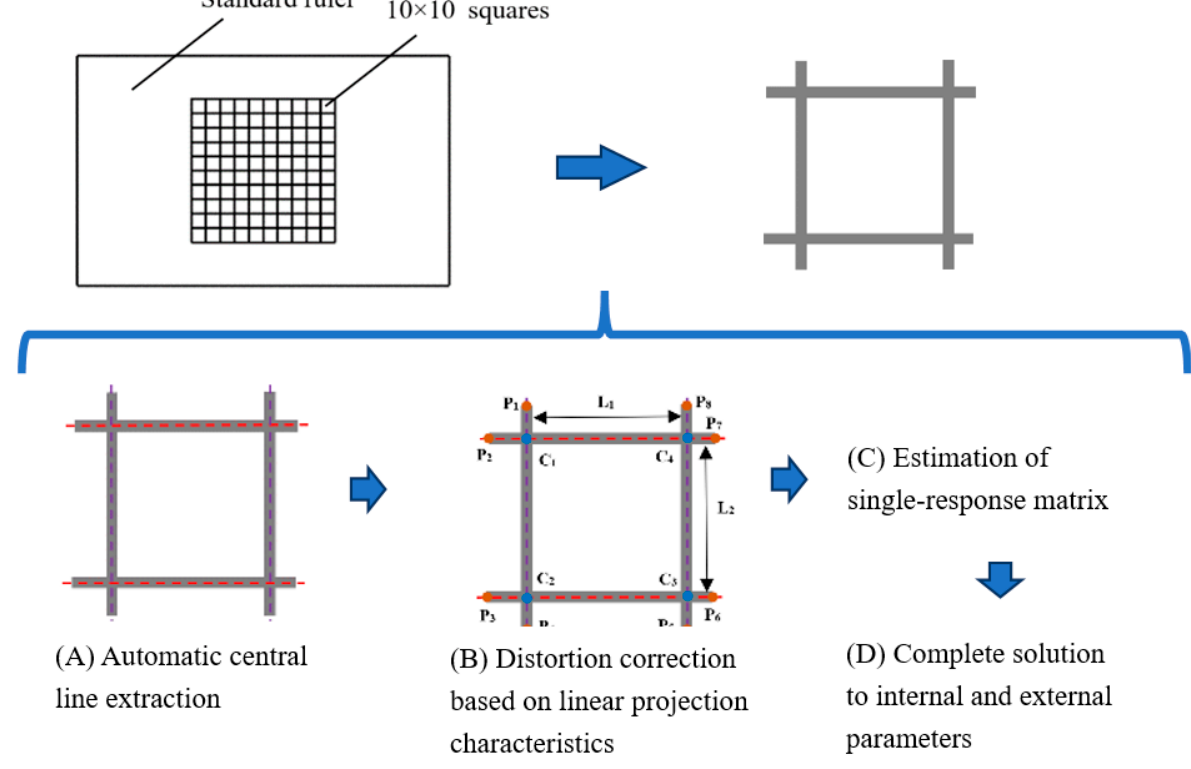
Figure 5. The process of image distortion Figure 5. T he process of image distortion error.